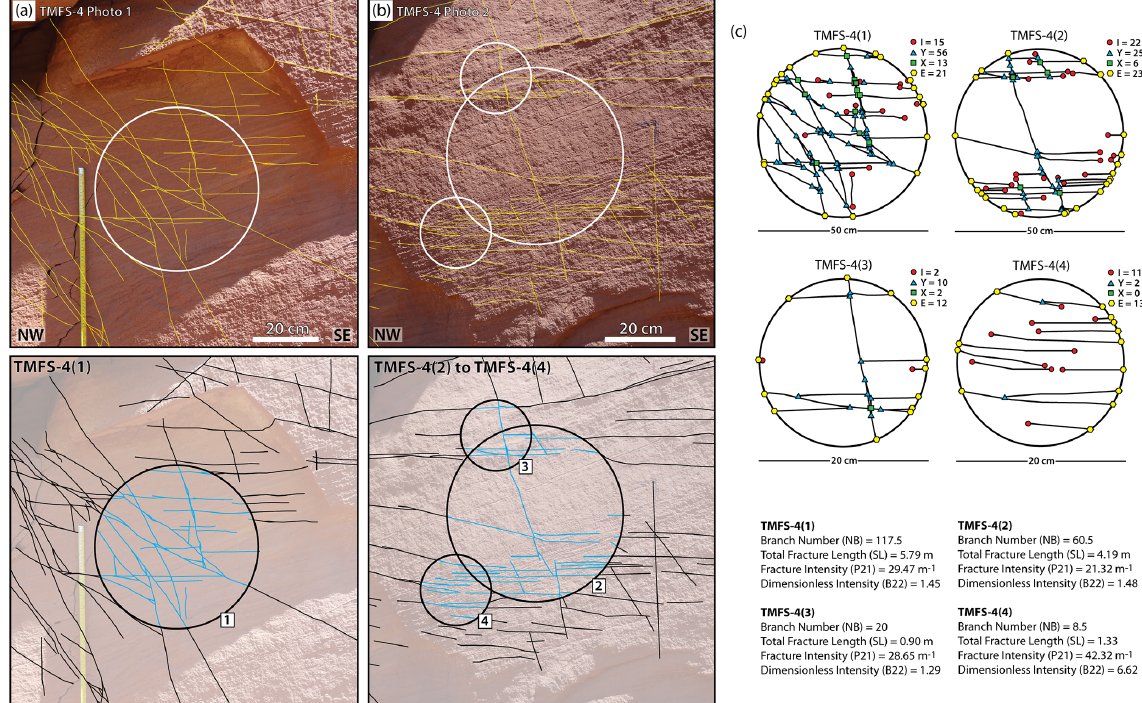
Figure A4. Sample station TMFS-4 scan circles (a, b) and nodal analysis (c) with statistics.